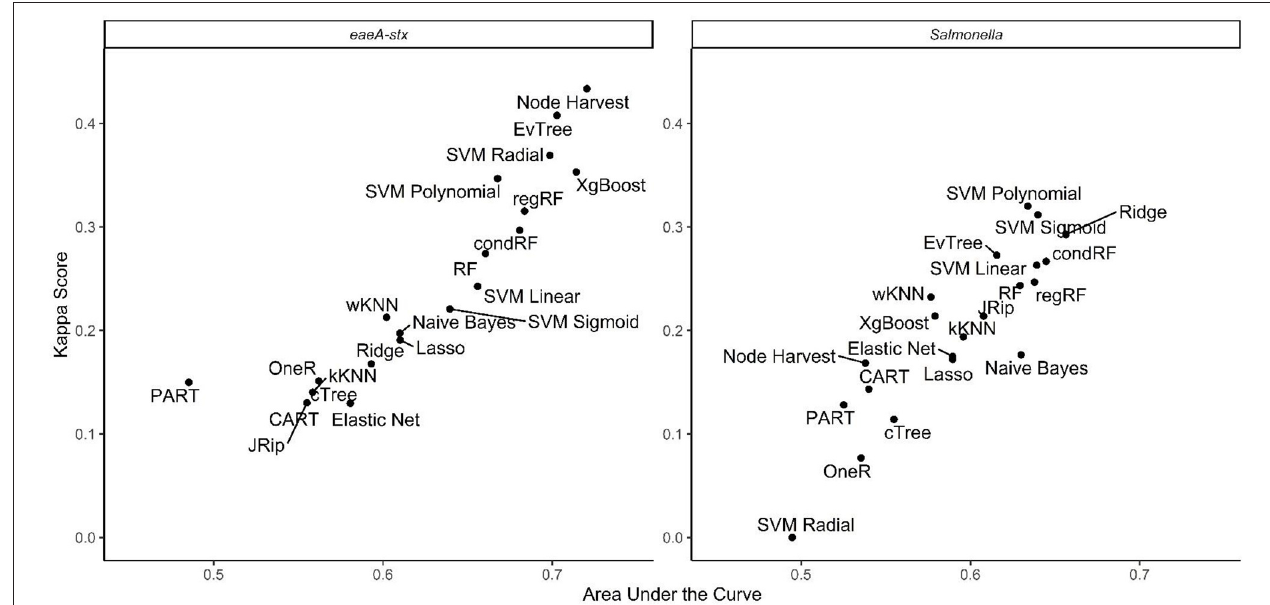
FIGURE 5 | Plot showing kappa score and area under the curve for the full